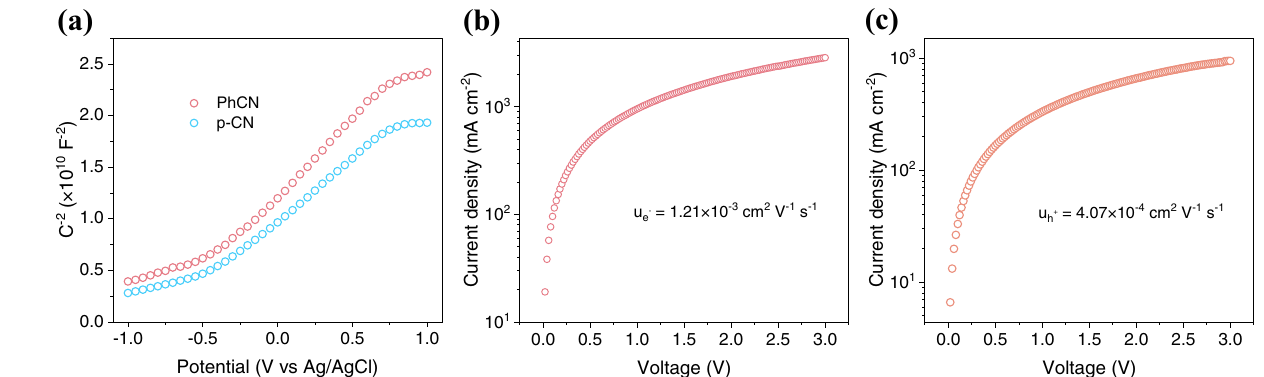
Fig.5|Physicalpropertiesofg-CNmaterials.a Mott – Schottkyplotsofp-CNandPhCNat1000Hzfrequencies. b Electronand c holemobilityofPhCNwerecalculatedby the SCLC